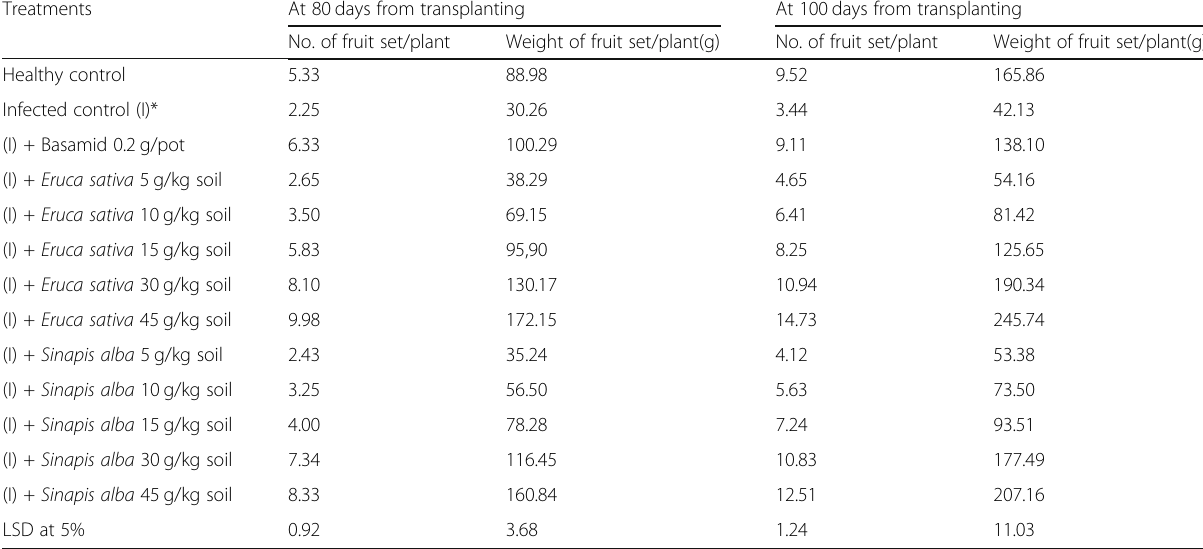
increases in the same yield parameter reached to 24.90 and 50.01%, respectively, over the corresponding healthy control and Basamid treatment (0.2 g/pot). It is obvious from the results that Essp treatment at 45 g/kg soil achieved an increase in the weight of fruit set/plant at 100 DFT reached to about the double of that recorded with the same treatment of Sasp in the same yield Table 5 Effect of different concentrations of both Eruca sativa L. and Sinapis alba L. seed powder and herbicide Basamid on number and weight of fruit set of Lycopersicon esculentum Mill. at 80 and 100 days from transplanting. (average of the two seasons) Treatments At 80 days from transplanting At 100 days from transplanting No. of fruit set/plant Weight of fruit set/plant(g) No. of fruit set/plant Weight of fruit